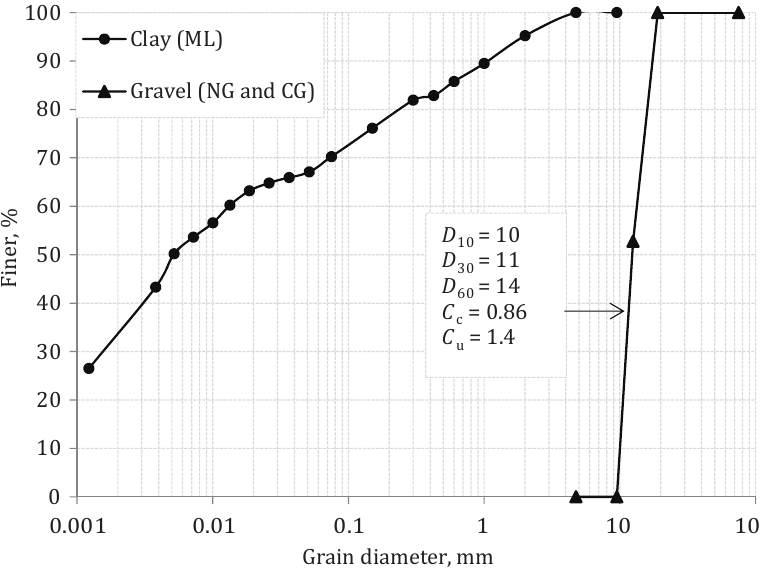
Figure 2. Grain size distribution for the clay and gravels used